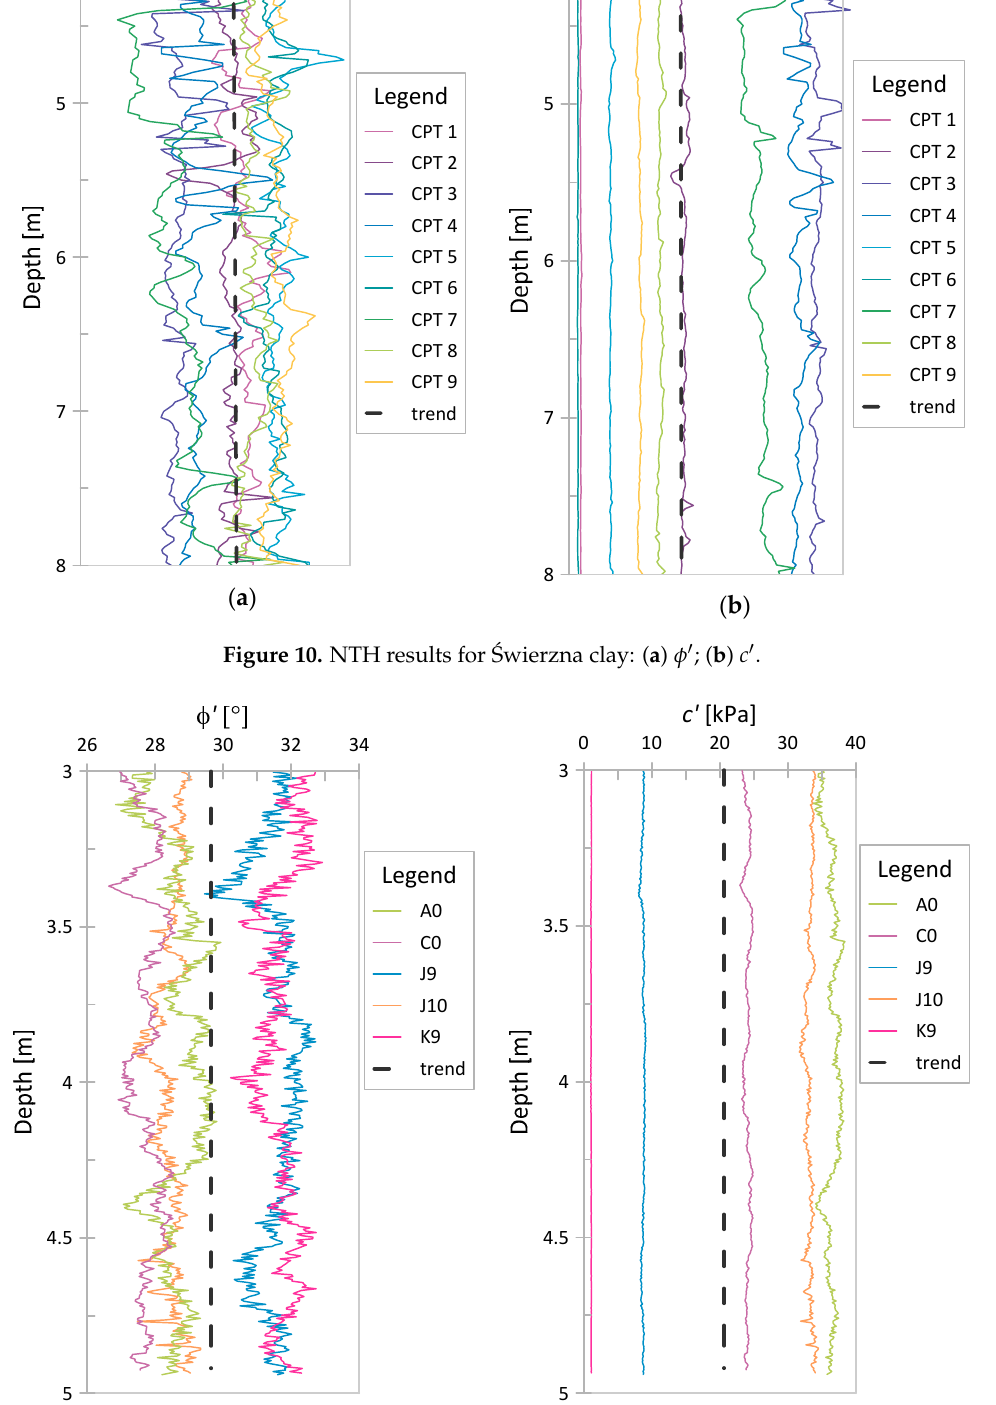
Figure 11. NTH results for Keswick clay: ( a ) ϕ ′ ; ( b ) c ′ . Table 6. Variability measures of parameters according to the NTH method.